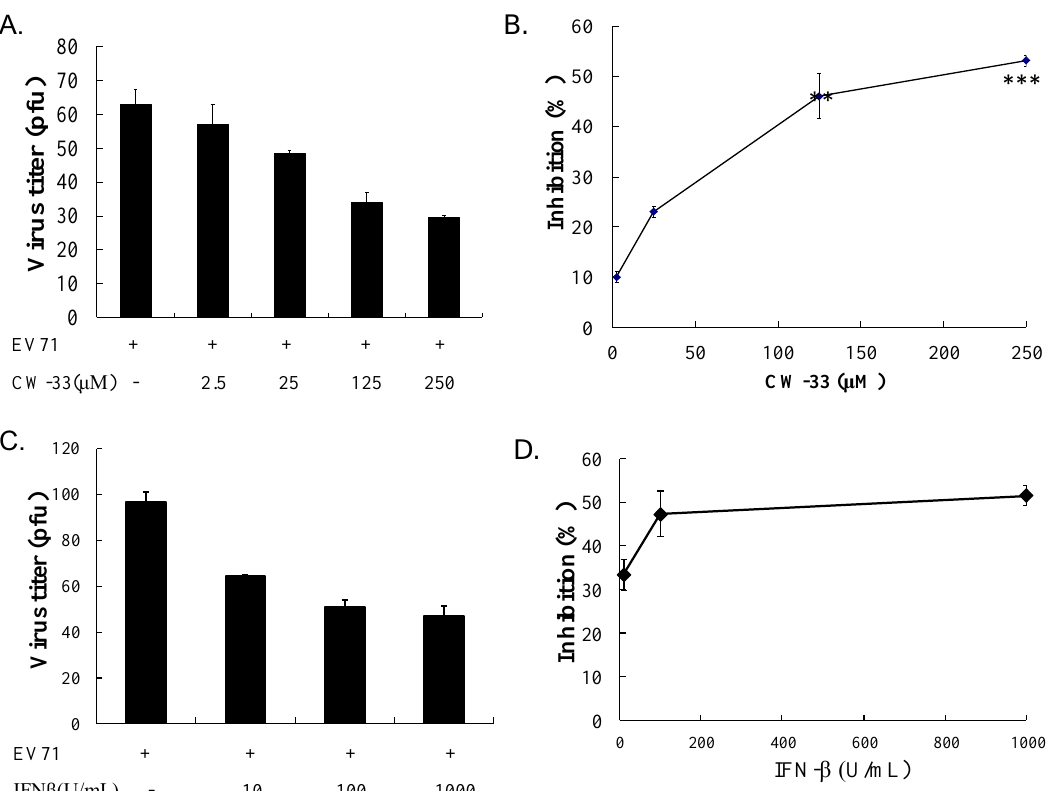
Figure 3. Inhibition of EV-A71 plaque formation by CW-33 or IFN- β alone. Monolayer of RD cells in 6-well plates were infected with EV-A71 (100 pfu), and then immediately treated with indicated concentrations of CW-33 ( A ) or IFN- β ( C ). After 1-h absorption, cell monolayer was washed with PBS, then overlaid with medium containing 1.5% agar.